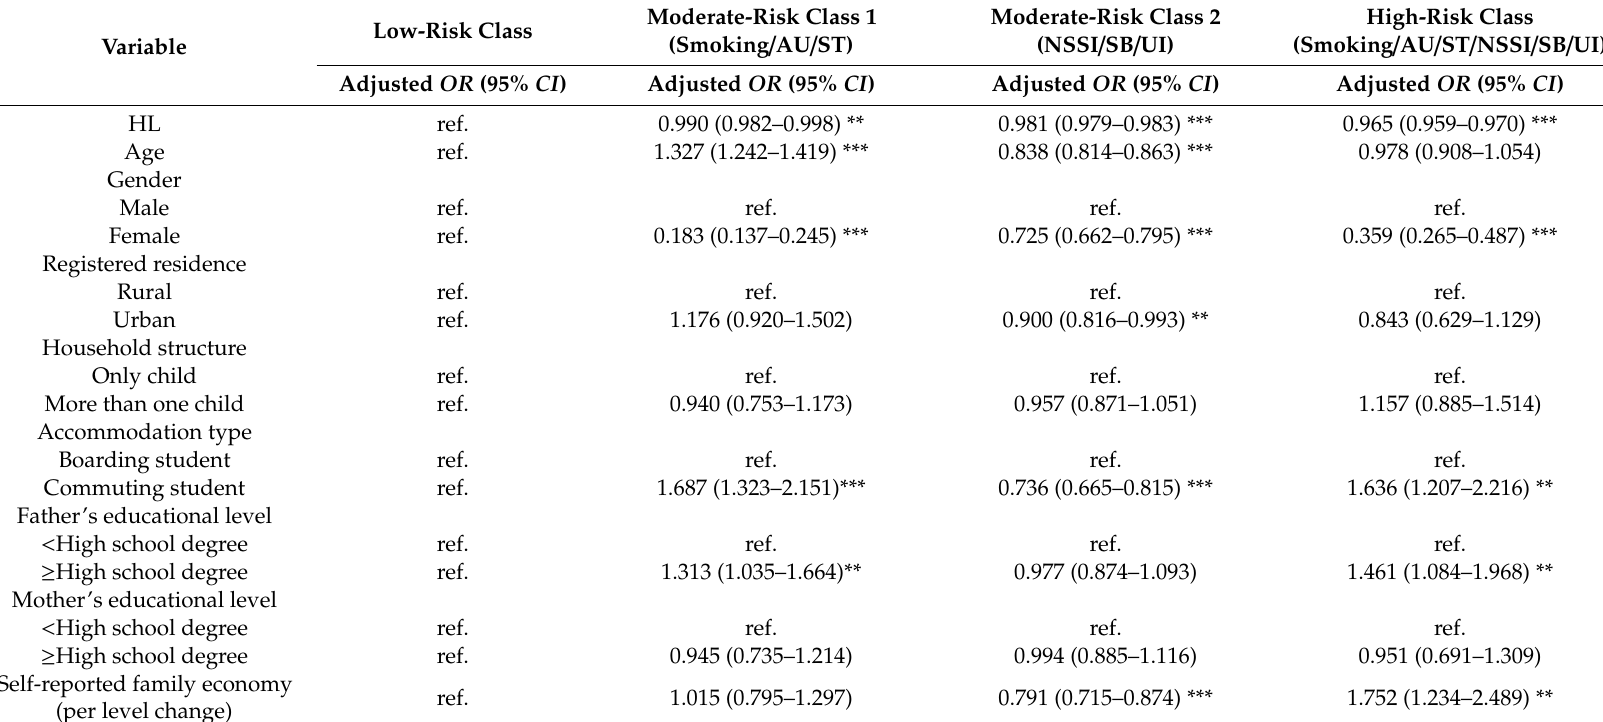
Table 3. Multinomial logistical regression predicting latent class